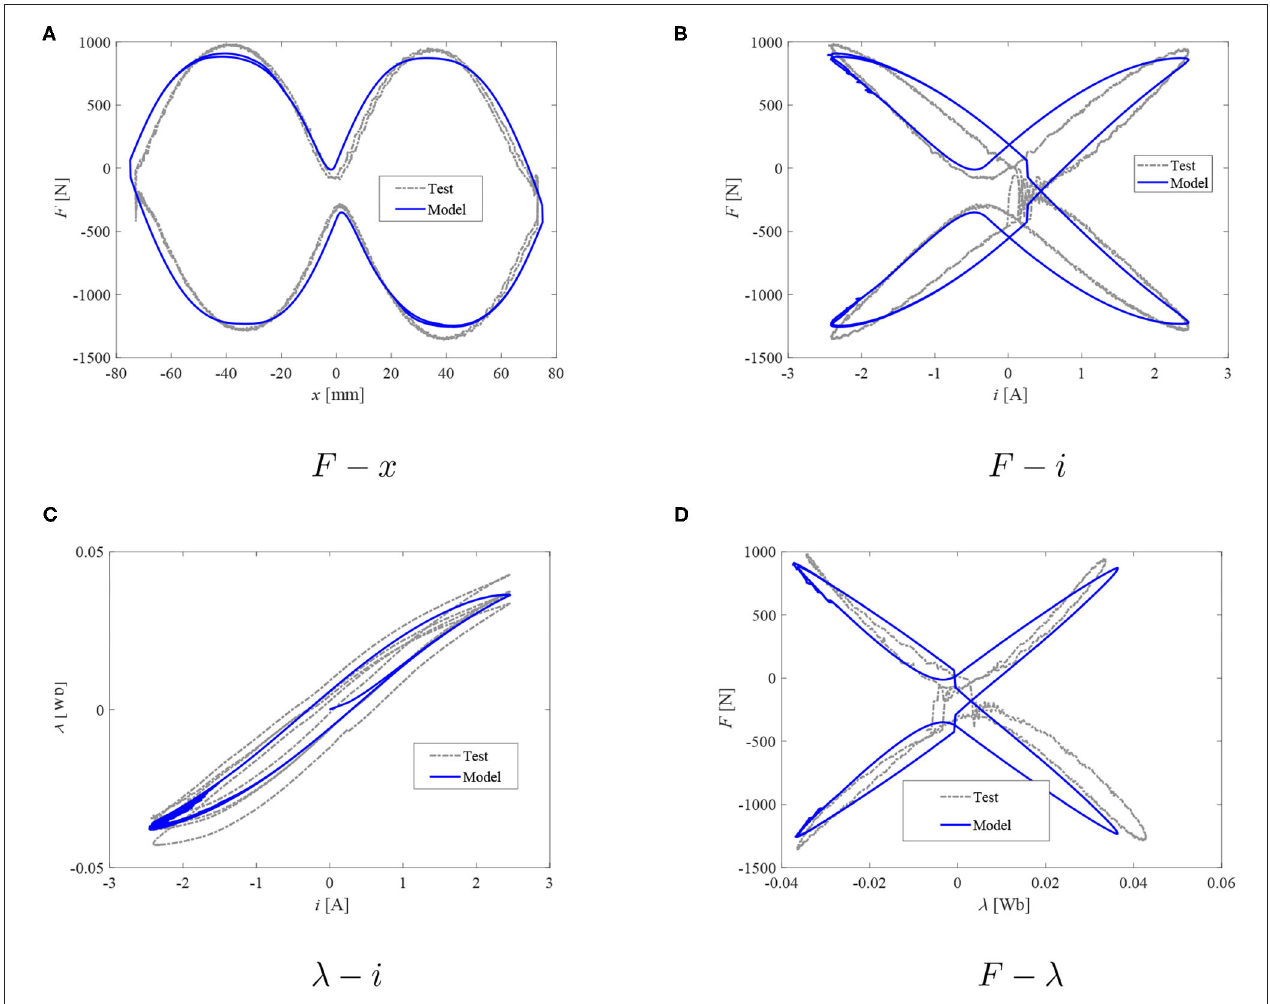
FIGURE 11 | Damper model: measured force and reconstructed flux vs. model data; I = 2.5 A. (A) F − x . (B) F − i . (C) λ − i . (D) F − λ